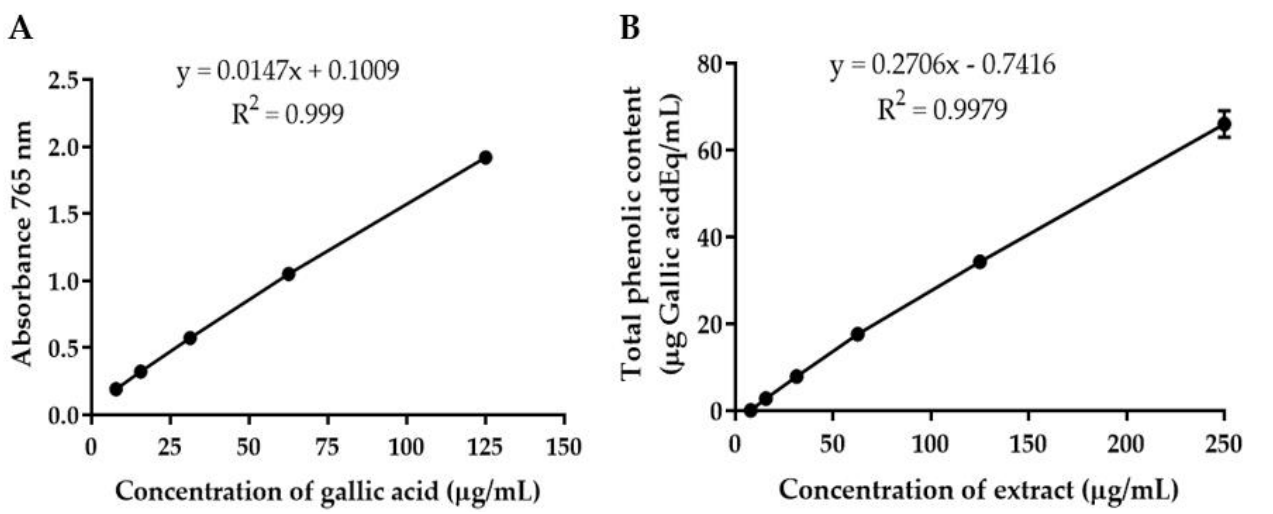
Figure 1. ( A ) Calibration curve of gallic acid. ( B ) Total phenolic content of B. flabellifer male flower ethanolic extract.